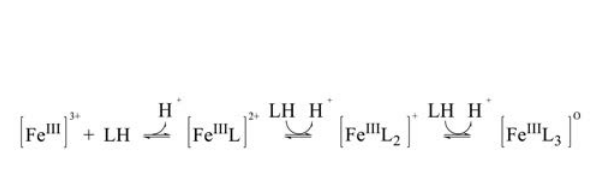
Figure 10. Formation of 3 different iron complexes formed from iron(III) and the bidentate ligand (L).